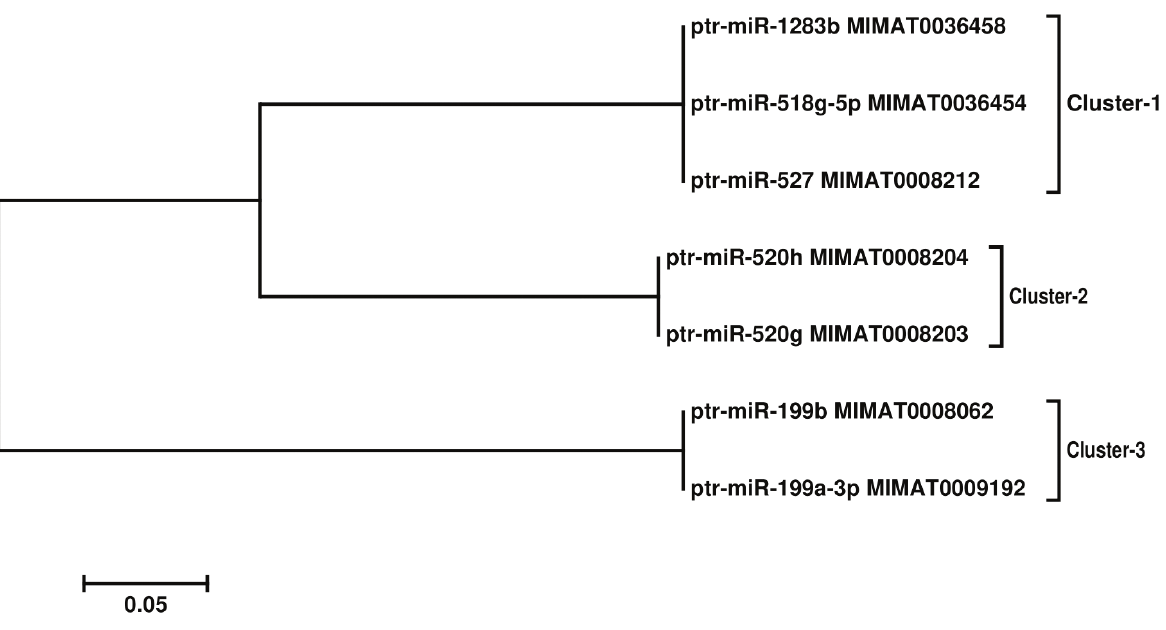
Figure 4. Represents evolutionary relationships of taxa for Pan troglodytes . The optimal tree with the sum of branch length = 0.71717172 is shown. The analysis involved 7 nucleotide